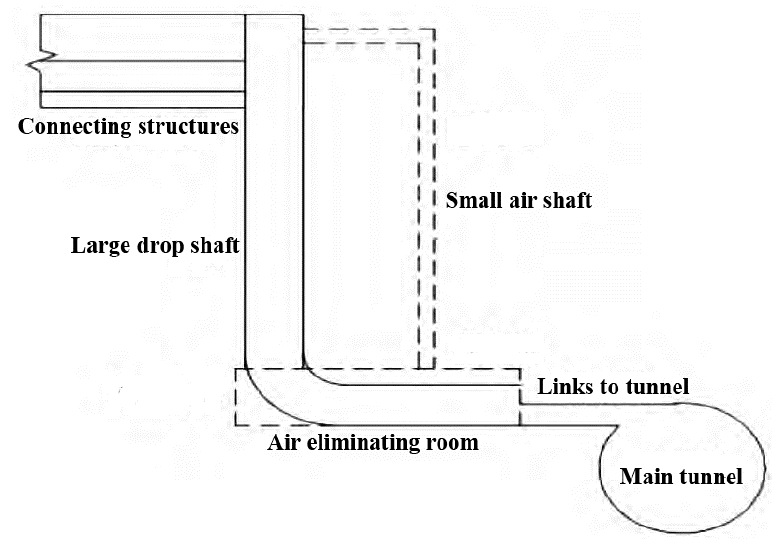
Figure 2. Schematic of drop shaft.